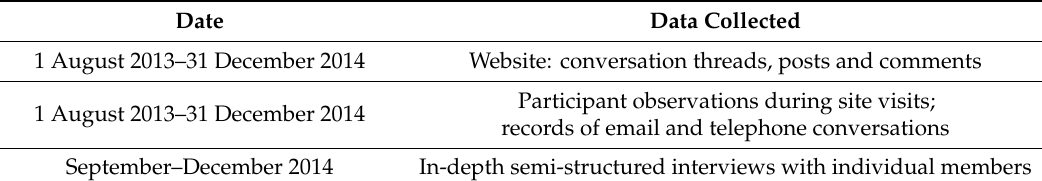
Table 1. SNAC study data collection timepoint and